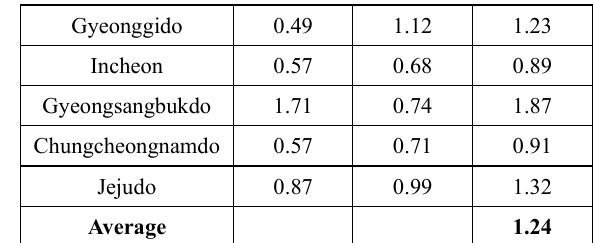
Table 8. Geolocation accuracy of precise orthoimage (South